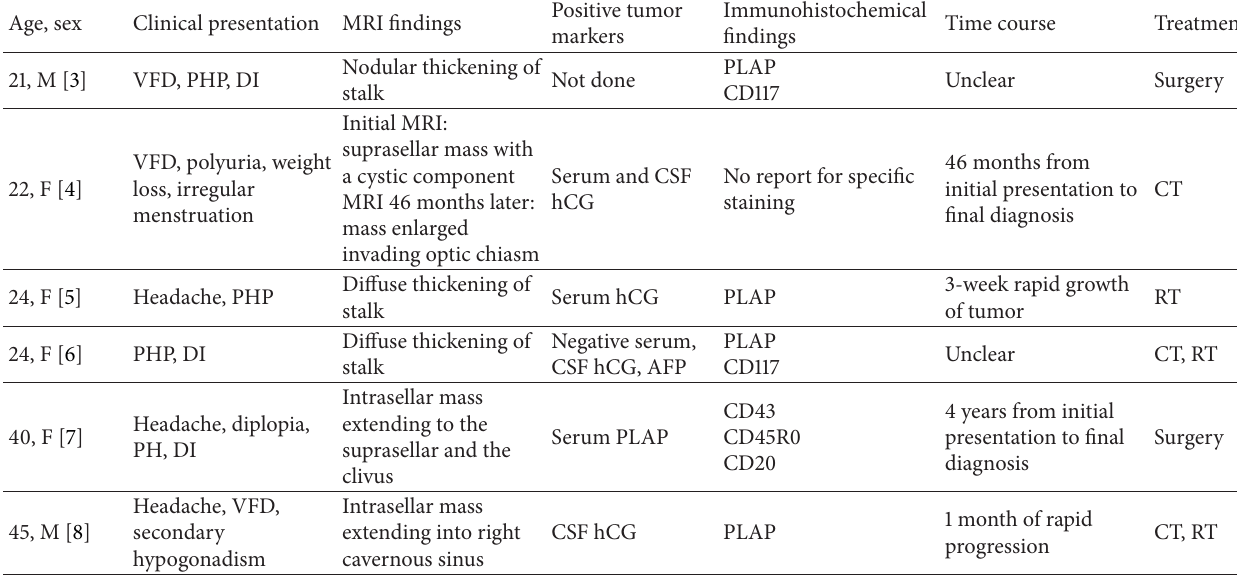
Table 2: Six adult cases of germinoma mimicking clinically LINH described in the